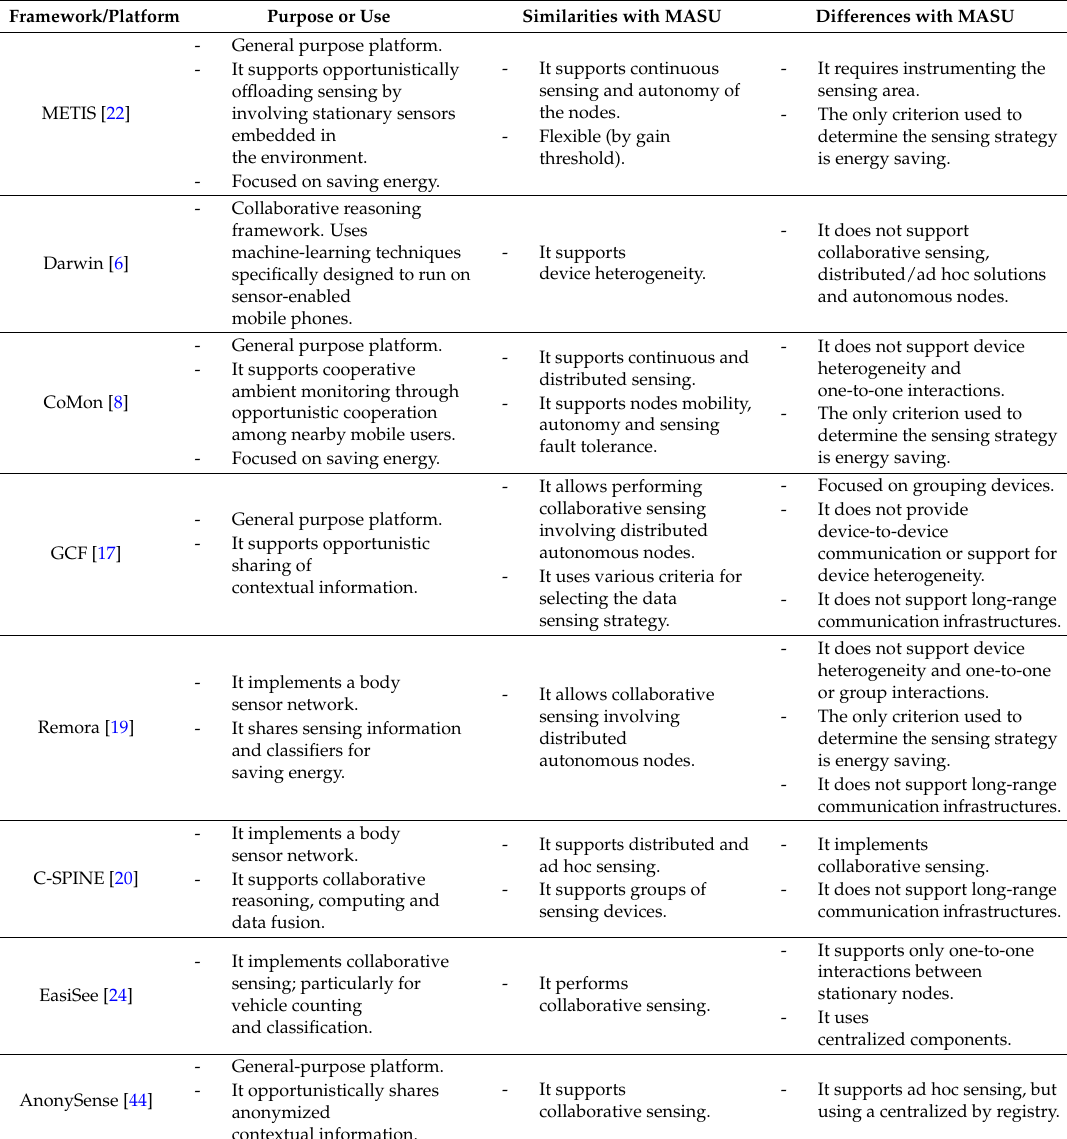
Table 7. Comparison between MASU and other